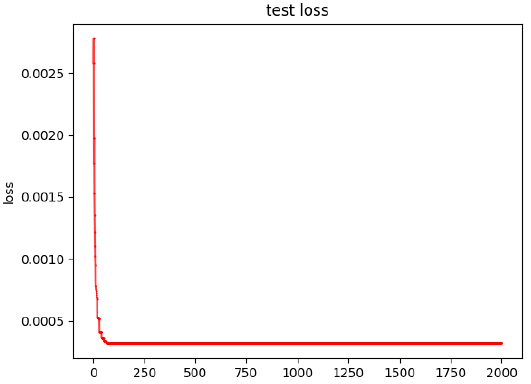
Figure 5. Loss rate of model testing.